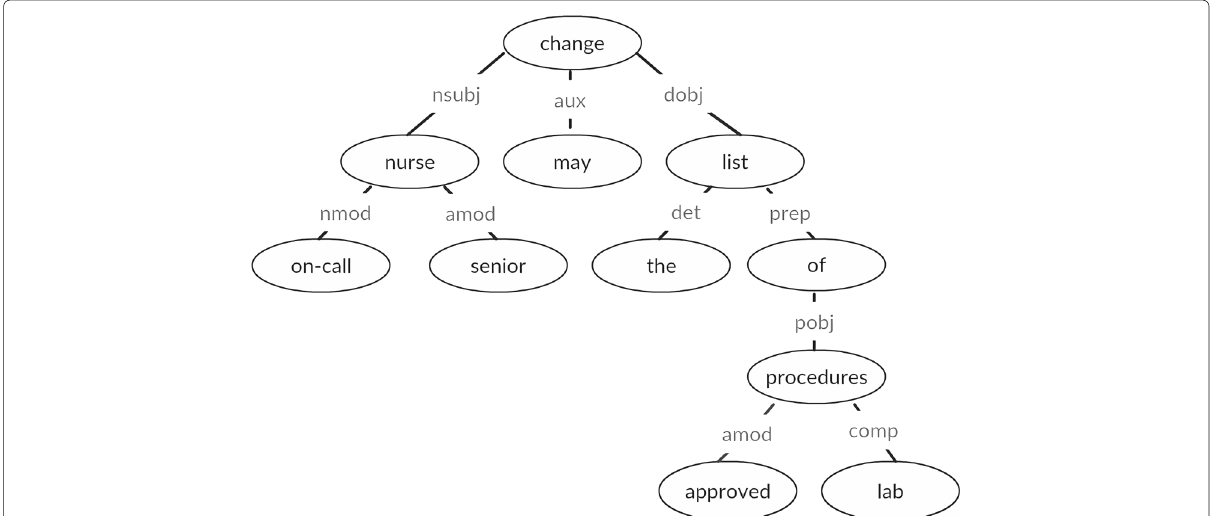
Fig. 5 Dependency tree